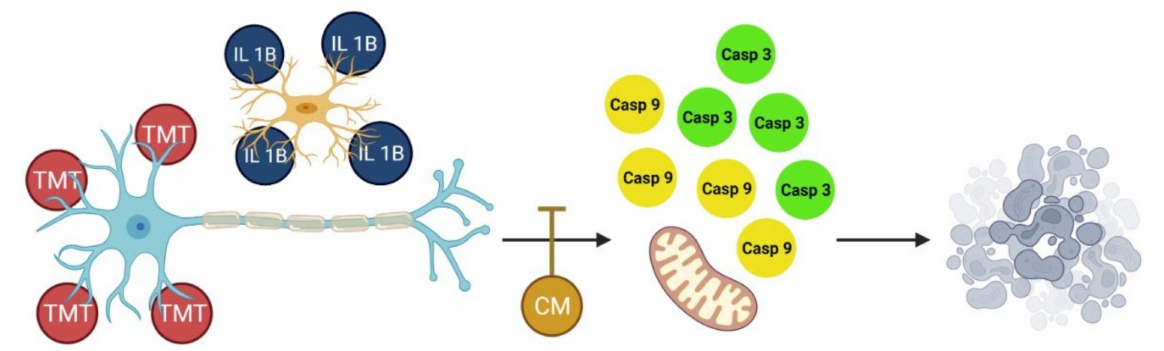
Figure 5. Through the in vitro neurodegenerative models presented in this manuscript, BUVEC-CM reduced the activity of IL-1 β and the expression of caspase-9 and caspase-3 in PC12 and SH-SY5Y cells induced by the neurotoxic agent TMT. This observation indicates the potential of BUVEC-CM as a neuroprotectant agent, particularly in neurodegenerative